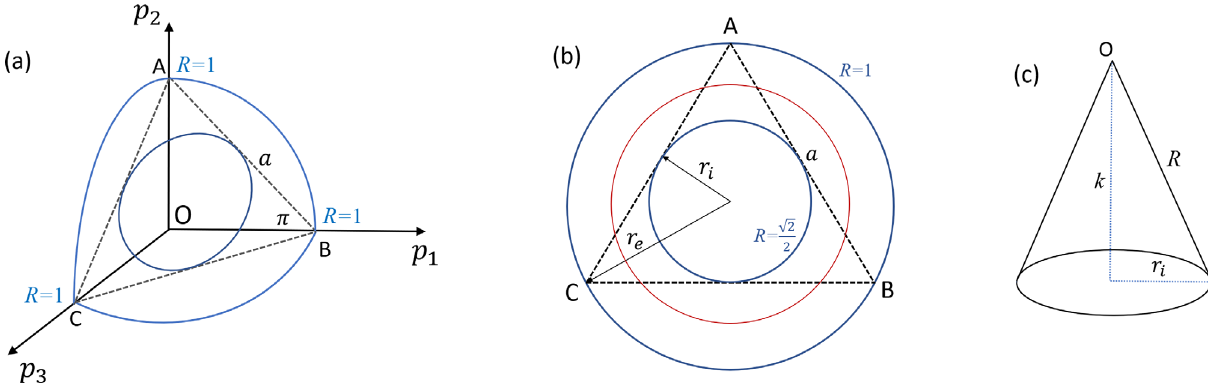
ffiffiffi p 2 . The inner circle is inscribed into the triangle.